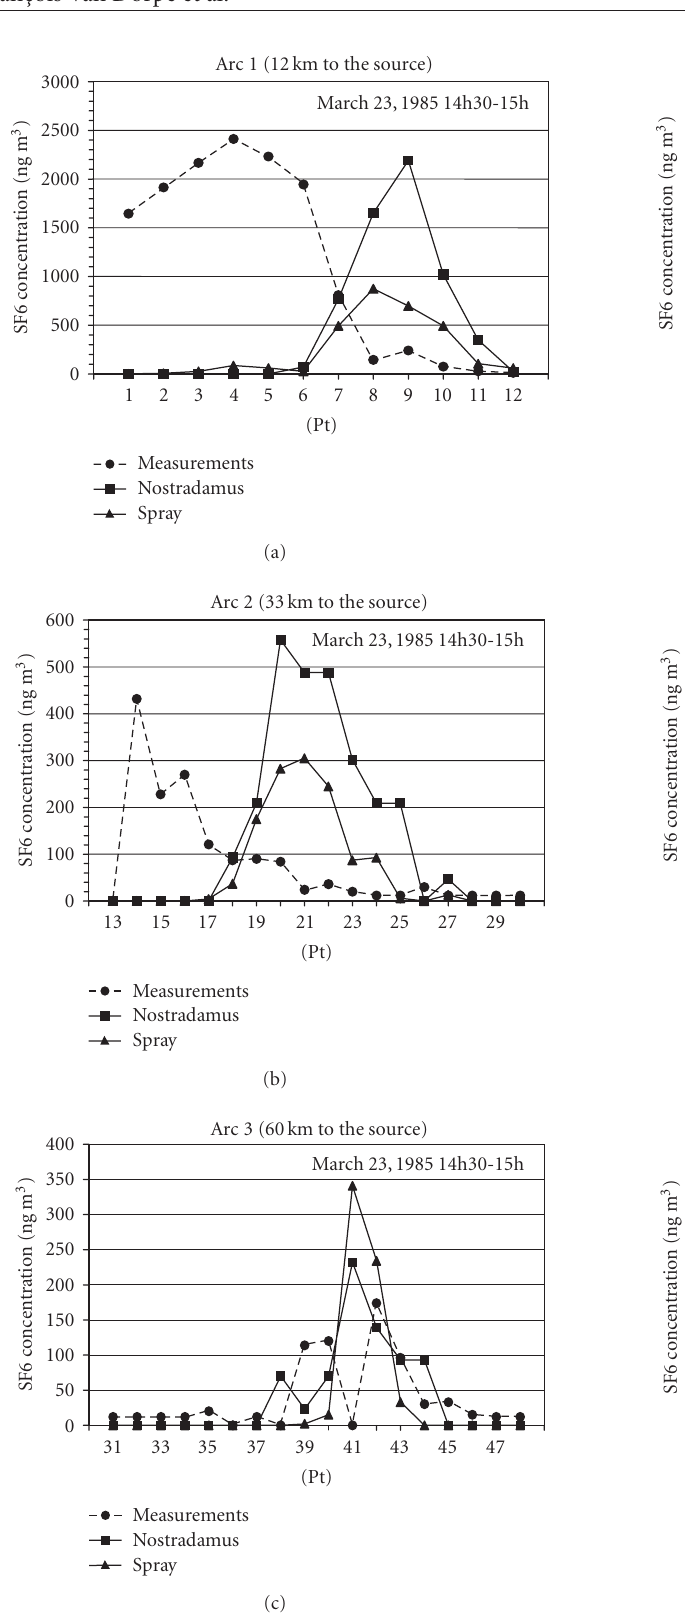
Figure 5: Comparison of SF6 concentration during experiment 3 on three arcs of monitoring points between measurements (at 1 meter above ground level) and NOSTRADAMUS and SPRAY cal- culations (at 10 meters above ground level).